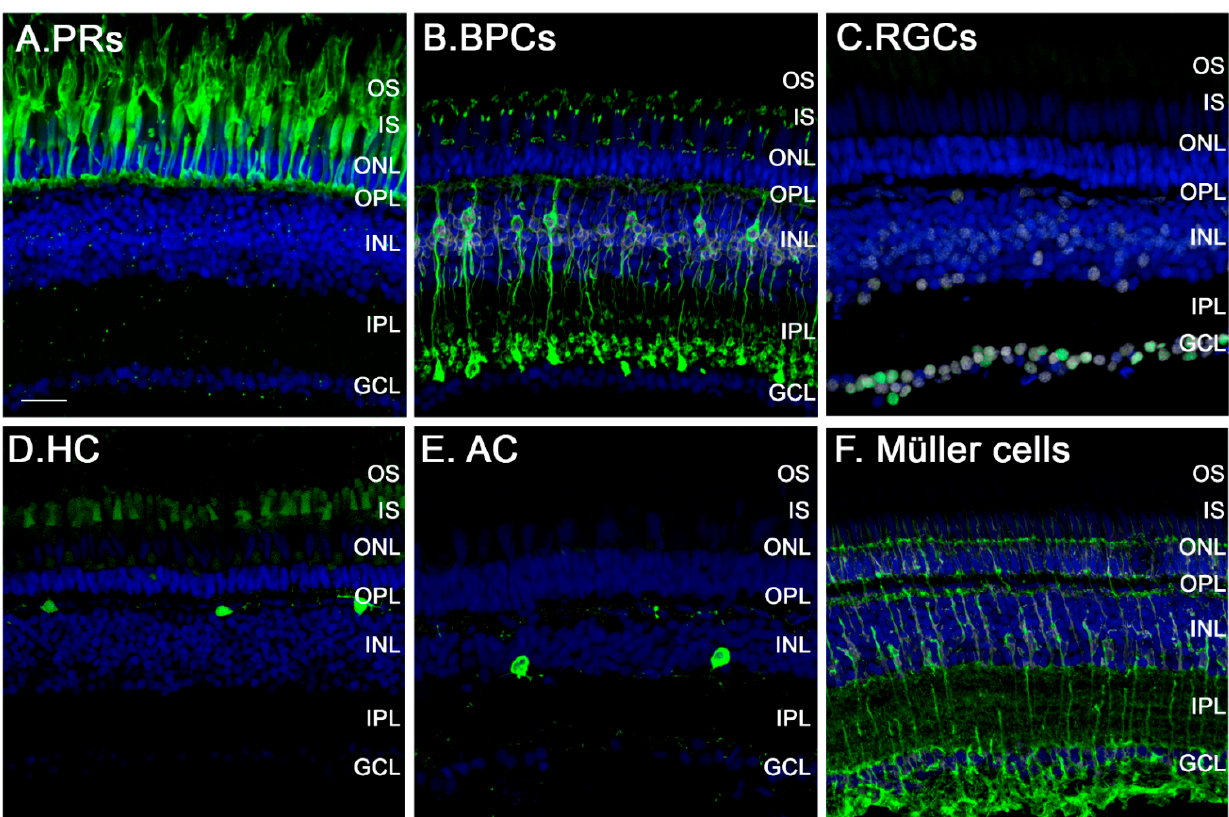
Figure 1. Neurons and glia in the zebrafish retina. Confocal image showing examples of neurons and glia (green) in the zebrafish retina: ( A ) anti-Zpr1 labels the double-cone (DC) photoreceptors; ( B ) anti-PKC α labels the large Mb-1 bipolar cells and all ON-bipolar cells; ( C ) anti-islet1/2 labels the RGCs, (although a few other cell types are labelled non-specifically in the INL); ( D ) transgenic Lhx1A zebrafish have GFP-labelled horizontal cells in the OPL; ( E ) anti-tyrosine hydroxylase labels the amacrine cells in the INL; ( F ) anti-glutamine synthetase to label the Müller glia. Nuclei are also labeled (blue). Other glial cells that are present in the zebrafish retina include microglia and astrocytes (not labeled). Abbreviations: PRs, photoreceptors; BPCs, Bipolar cells; RGCs, retinal ganglion cells; HC, Horizontal cells; AC, Amacrine cells; OS, outer segments; IS, inner segments; ONL, outer nuclear layer; OPL, outer plexiform layer; INL, inner nuclear layer; IPL, inner plexiform layer; GCL, ganglion cell layer. Scale bar = 20 µm.